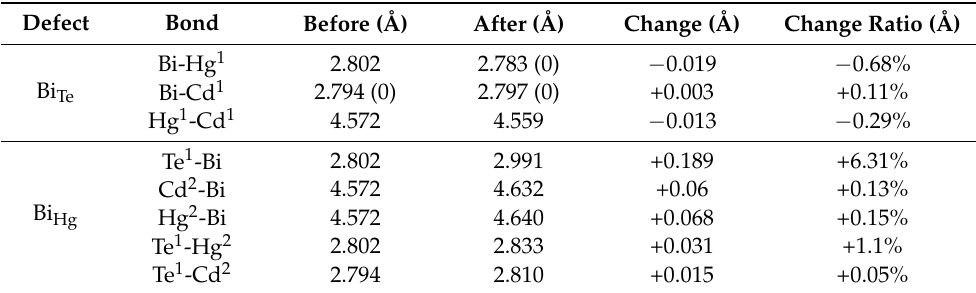
Table 1. The relaxation results of Bi-doped Hg 0.75 Cd 0.25